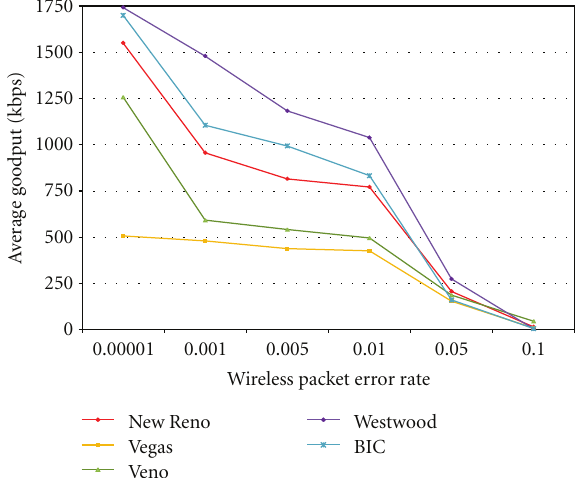
Figure 12: Average Goodput for various DL :UL ratios (PER = 10 − 5 ).